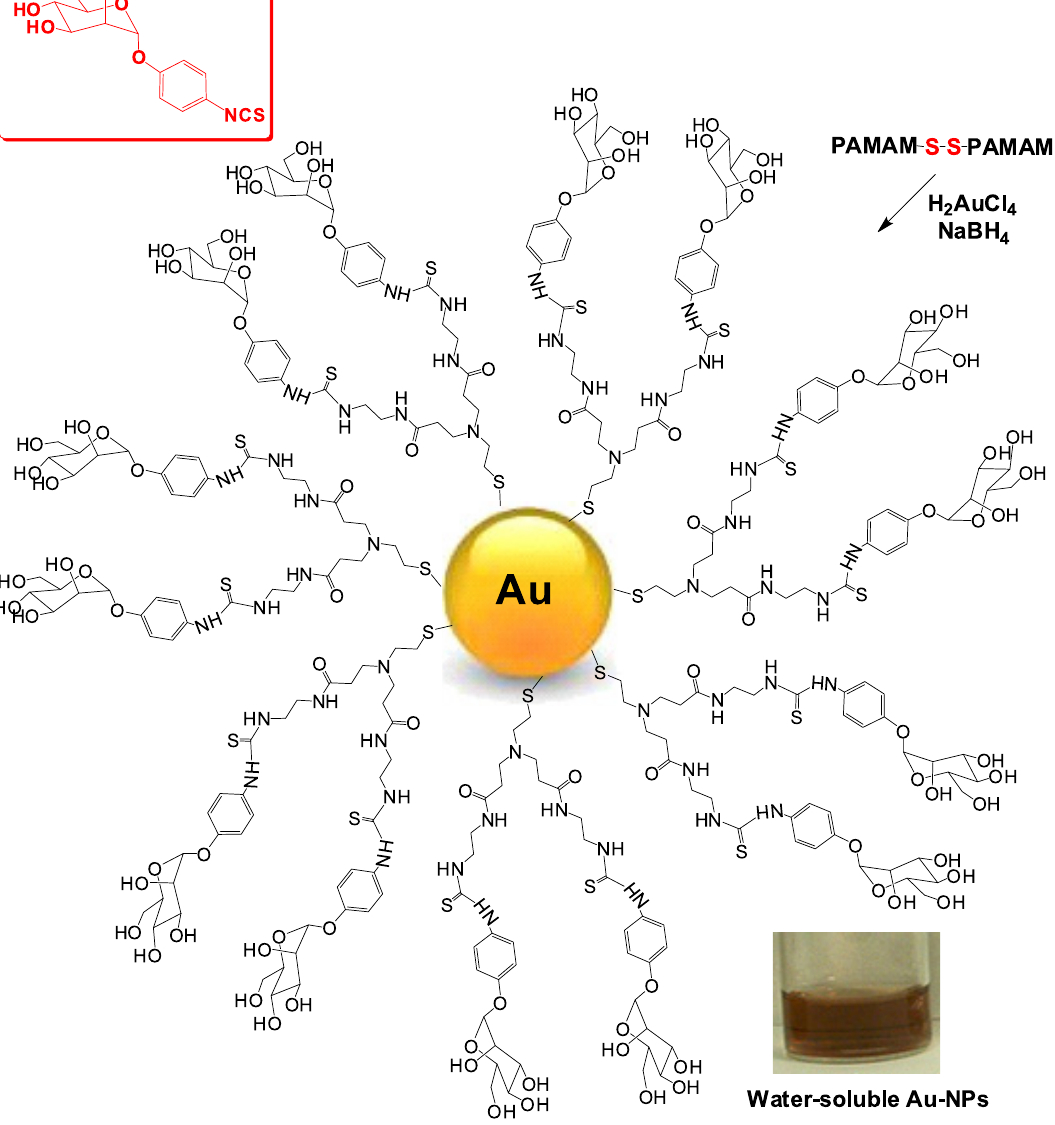
FIGURE 16 – Water-soluble Gold-NPs constructed with surrounding PAMAM dendrimers to which were linked thioureas ending with mannopyranoside